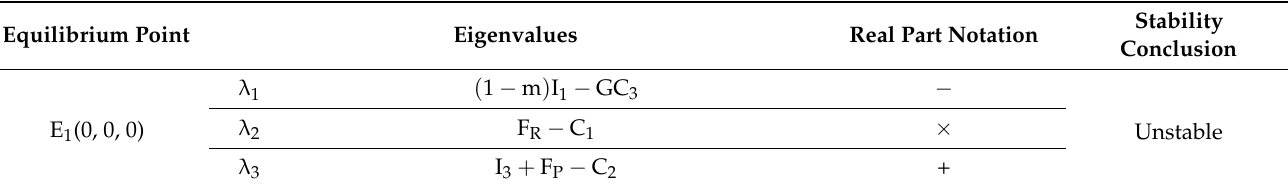
Table 4. Equilibrium point of the system and